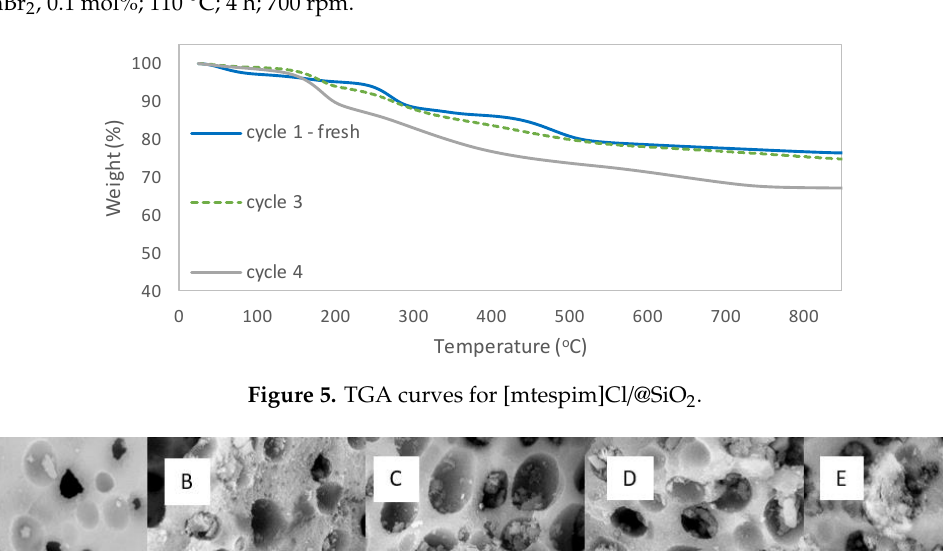
Figure 4. Catalyst recycling tests. Reaction conditions: SO, 0.13 mol; [mtespim]Cl/@SiO 2 , 0.5 mol%; ZnBr 2 , 0.1 mol%; 110 °C; 4 h; 700 rpm.